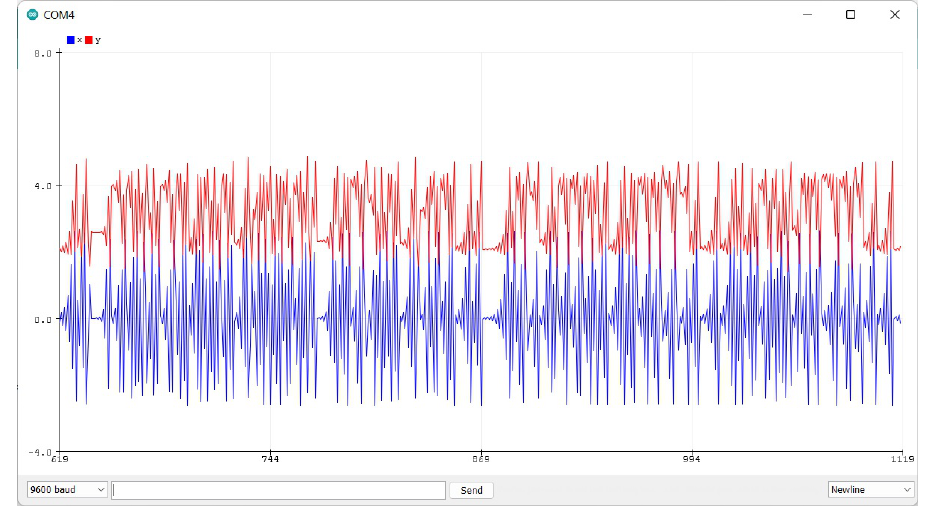
Figure 9. Experimental result indicates